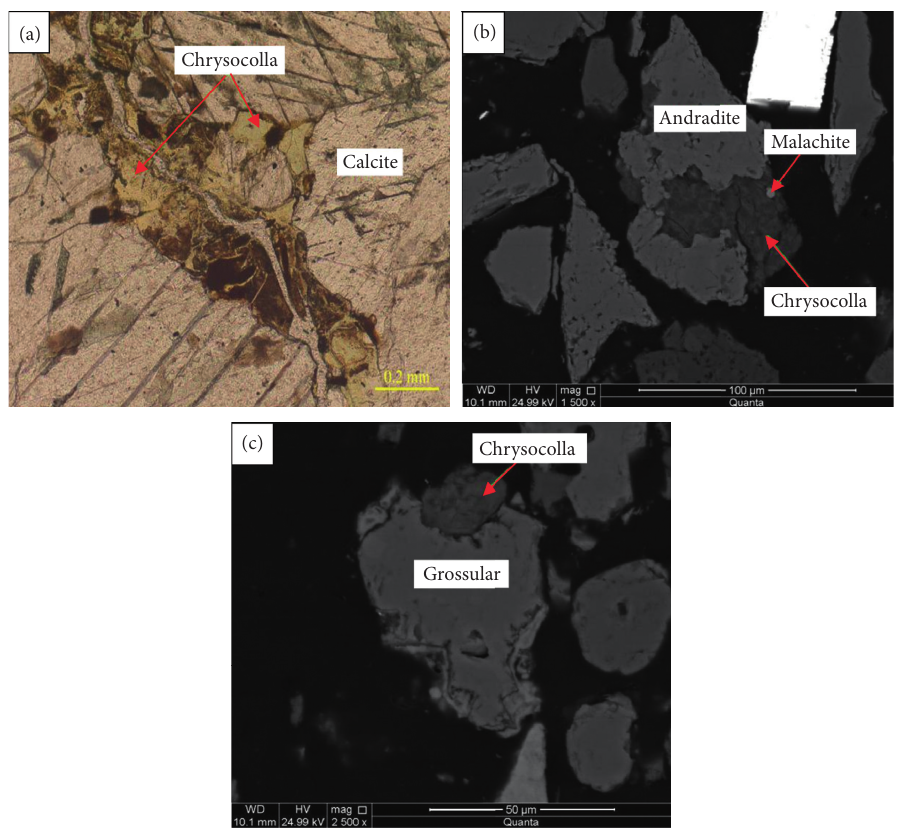
Figure 7: Embedded characteristics of